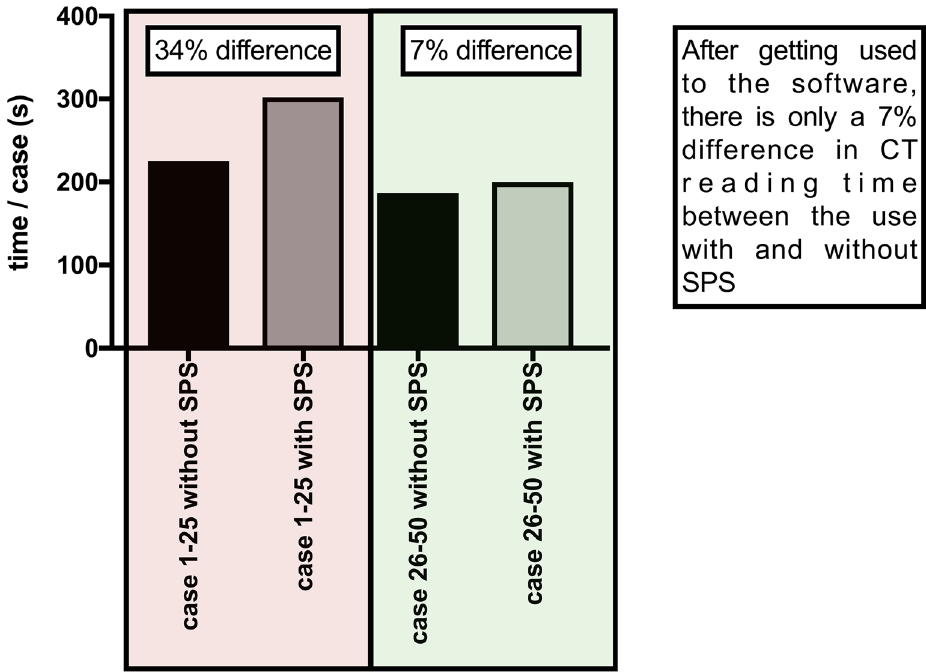
Figure 6. Mean time/case in seconds of the first 50% and the last 50% of cases without SPS and with SPS.